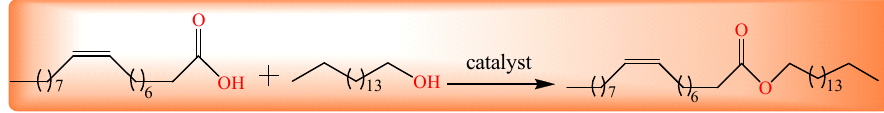
Figure 1. Synthesis of cetyl oleate through esterification.